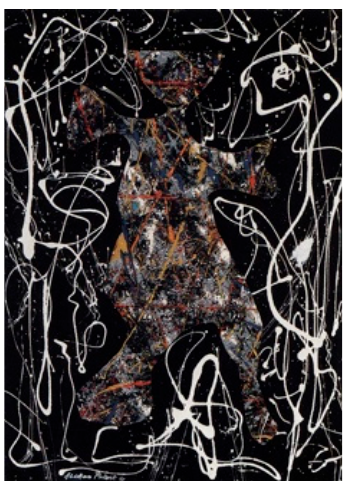
Figure 19. Jackson Pollock, Cut-Out Figure, 1948. 78.8 × 57.5 cm. Private Collection, Montreal. © 2022 The Pollock-Krasner Foundation/Artists Rights Society (ARS), New York.